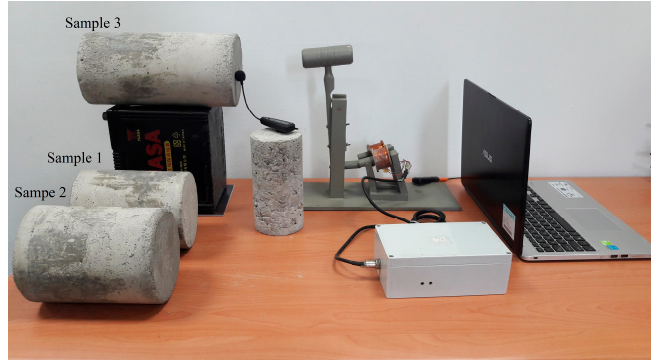
Figure 9. Experimental setup of the overall system.